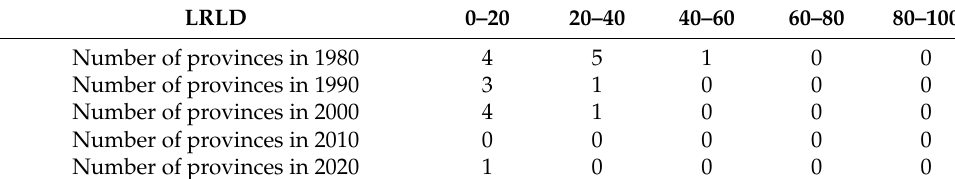
Table 4. Statistics of the LRLD of China’s major grain-producing areas in 1980, 1990, 2000, 2010, and 2020.